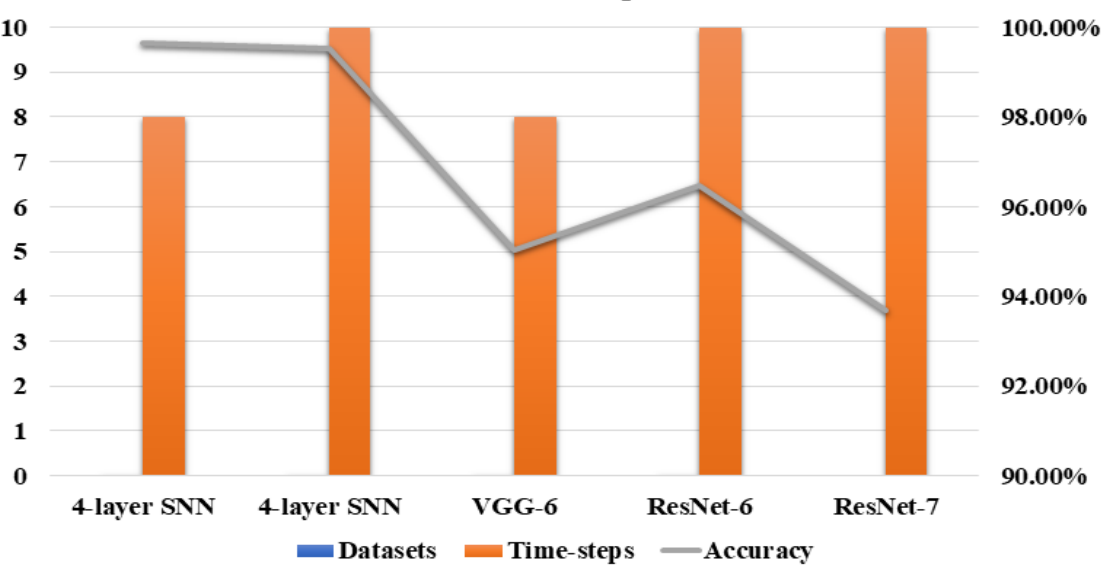
Figure 11. Classfication Performance w.r.t time-steps over MNIST, KITTI and License Plate